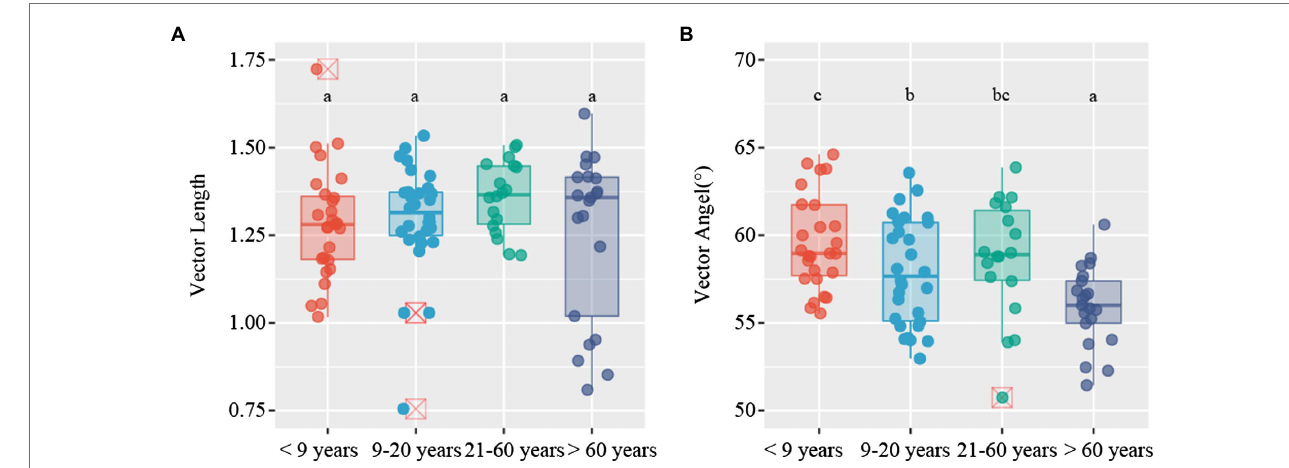
FIGURE 3 | Variations in vector characteristics for Camellia oleifera plantations of different stand ages. (A) vector length; (B) vector angle. Different letters denote significant differences among stand ages ( p <